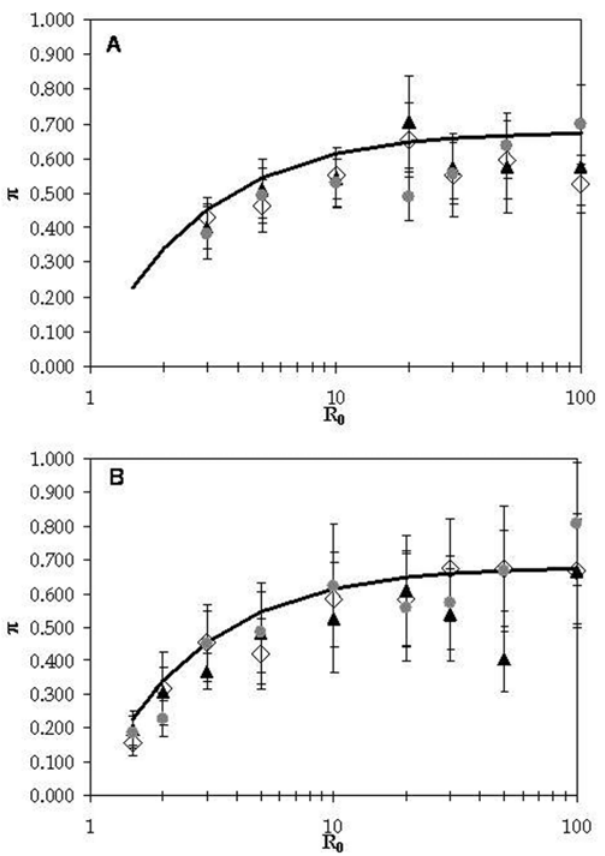
Figure 3. The level of genetic diversity in the pathogen population as a function of R 0 . Transmission is governed by the SIR model (1). Parameter values are as follows D =30000, e =0.1 U =0.00005 and b =0.005 (in panel A) and U =0.00002 and b =0.015 (in panel B), N d =5 for filled triangles, N d =10 for empty diamonds and N d =20 for grey circles. The solid black line is the expected level of diversity as given by equation (4). In panel A for the lowest values of R 0 the pathogen population could not be maintained.